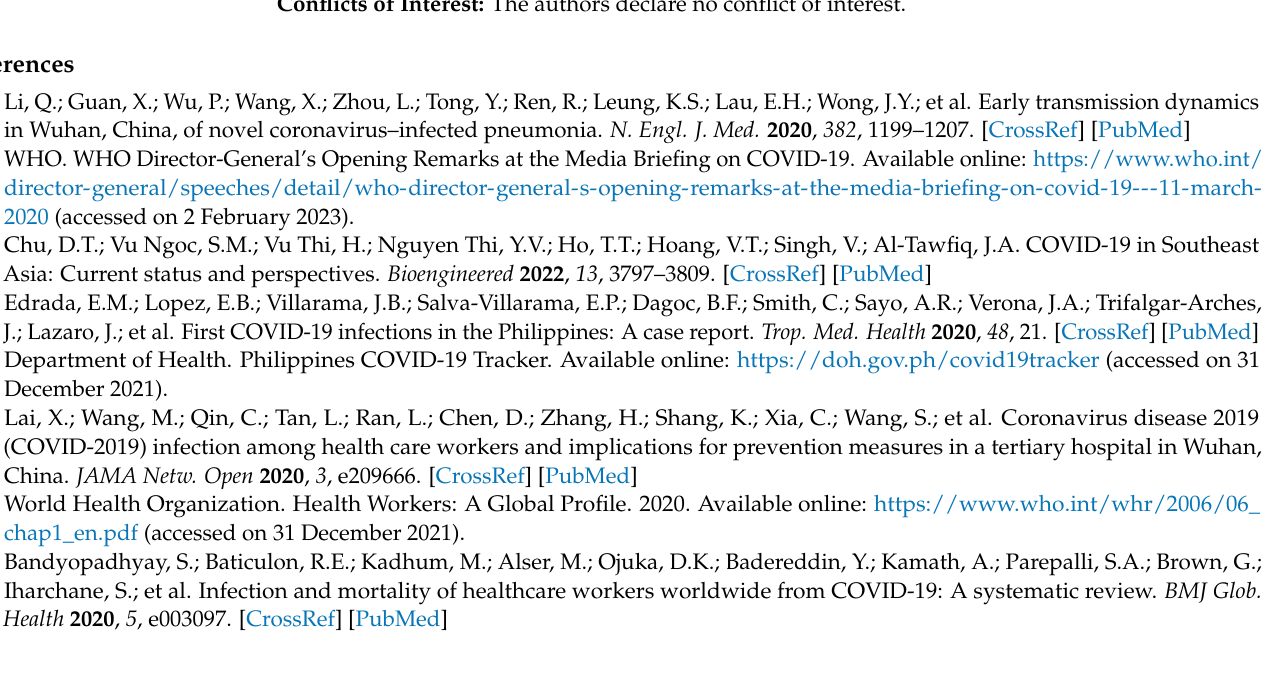
Table S2: IPC Assessment Tool for Temporary Treatment and Monitoring